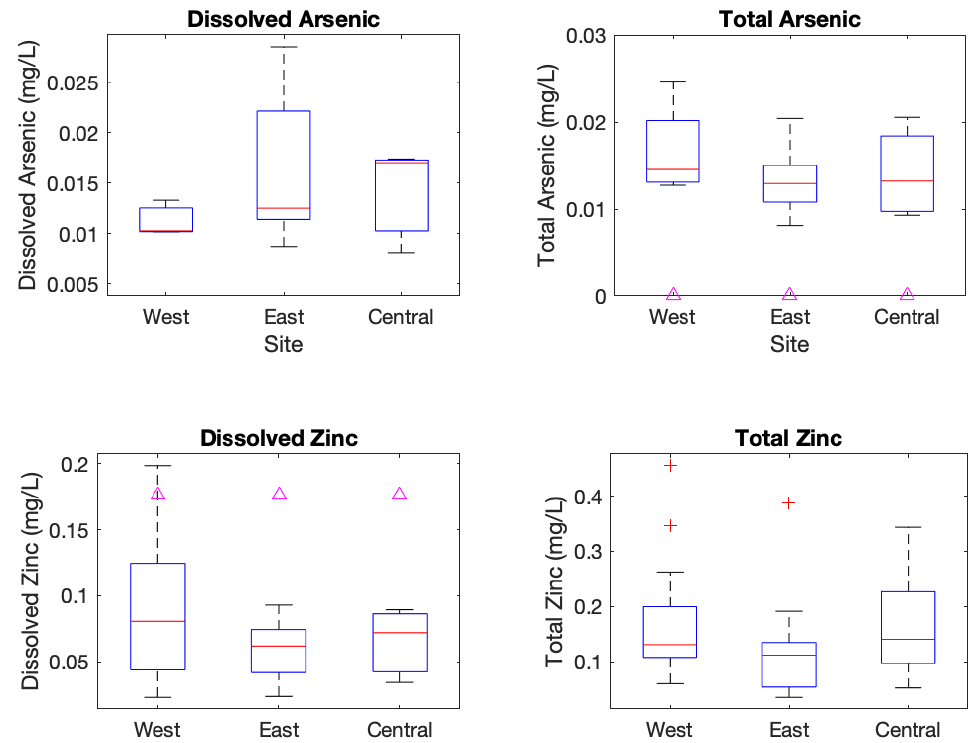
Figure A4. Wet weather water quality—arsenic and zinc boxplots. Red plus signs indicate outliers and triangles represent CDPHE in-stream standards, where relevant.